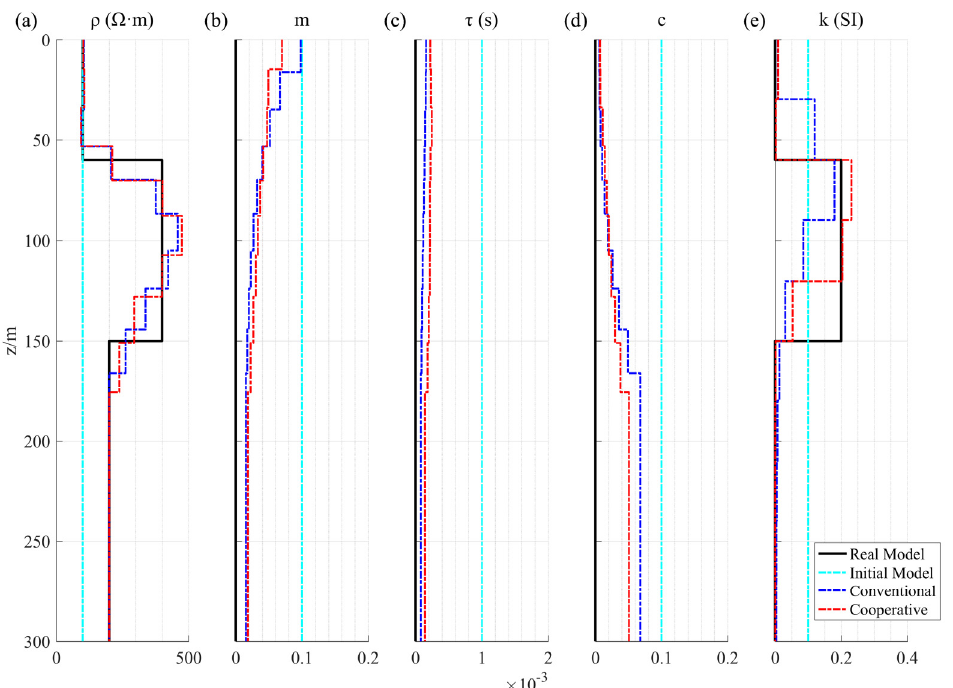
Figure 15. Results of the petrophysical parameters’ inversion at 200 m: ( a ) resistivity; ( b ) chargeability; ( c ) time constant; ( d ) frequency dependence; ( e ) permeability.